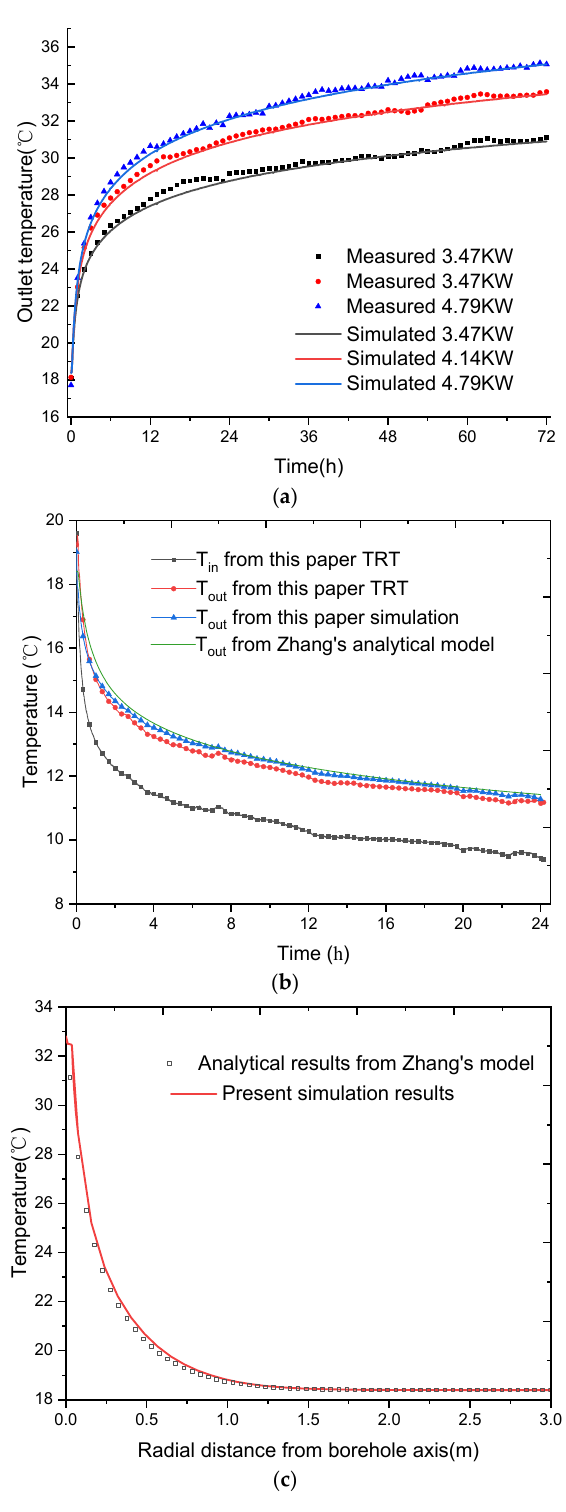
Figure 2. ( a ): Comparison between the results from the simulative model built in this research and experimental data from Zhou et al. [20]. ( b ): The simulative model built in this research was compared with the results from TRT experimental data and Zhang’s model [21]. ( c ): Comparison of the radial soil temperature (at y = 0 m and z = 41 m) from the simulative model built in this research and the analytical solution from Zhang’s model